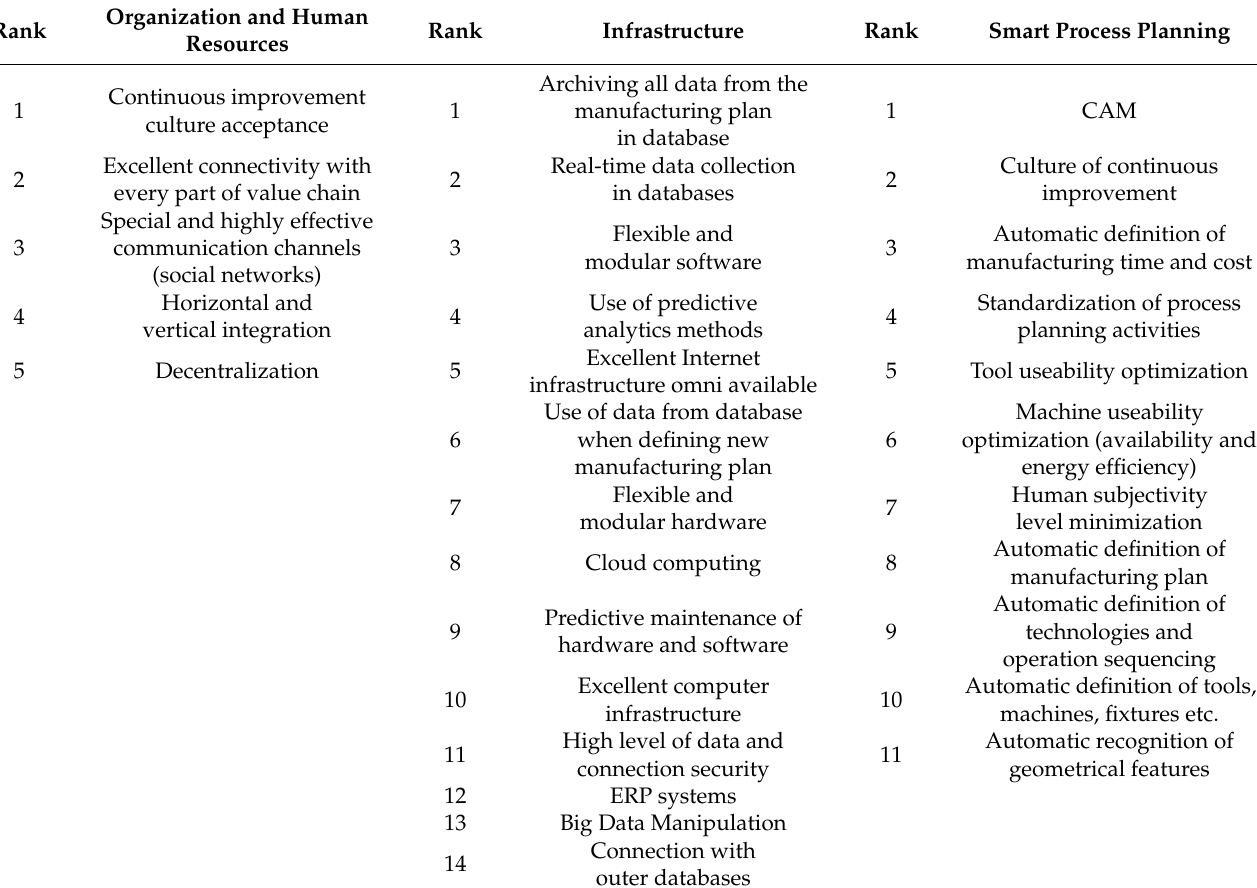
Table 8. Industry 4.0 elements strategic implementation priorities for process planning—case